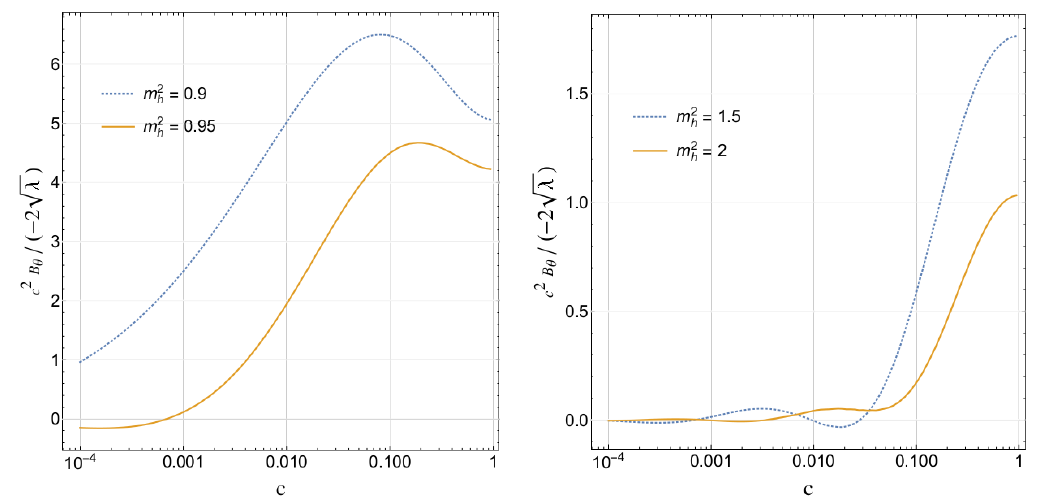
Figure 9 . The bispectrum B (cid:18) due to Higgs-in(cid:13)aton exchange processes of the intermediate-type (left panel) and the equilateral-type with oscillatory signatures (right panel). Parameters (cid:21) = 0 : 01 and (cid:3) = 2 are used, and m h is in Hubble